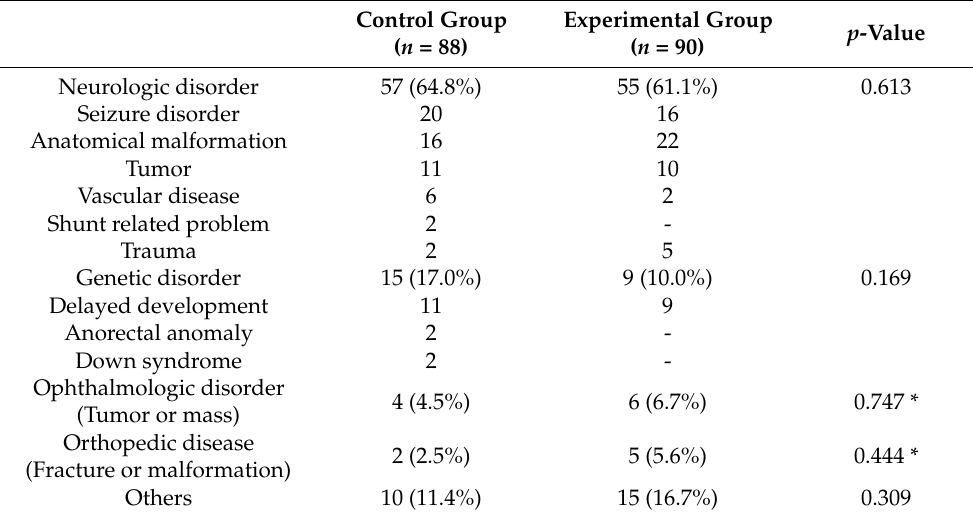
Table 2. Underlying diseases of children undergoing sedation for MRI scan.